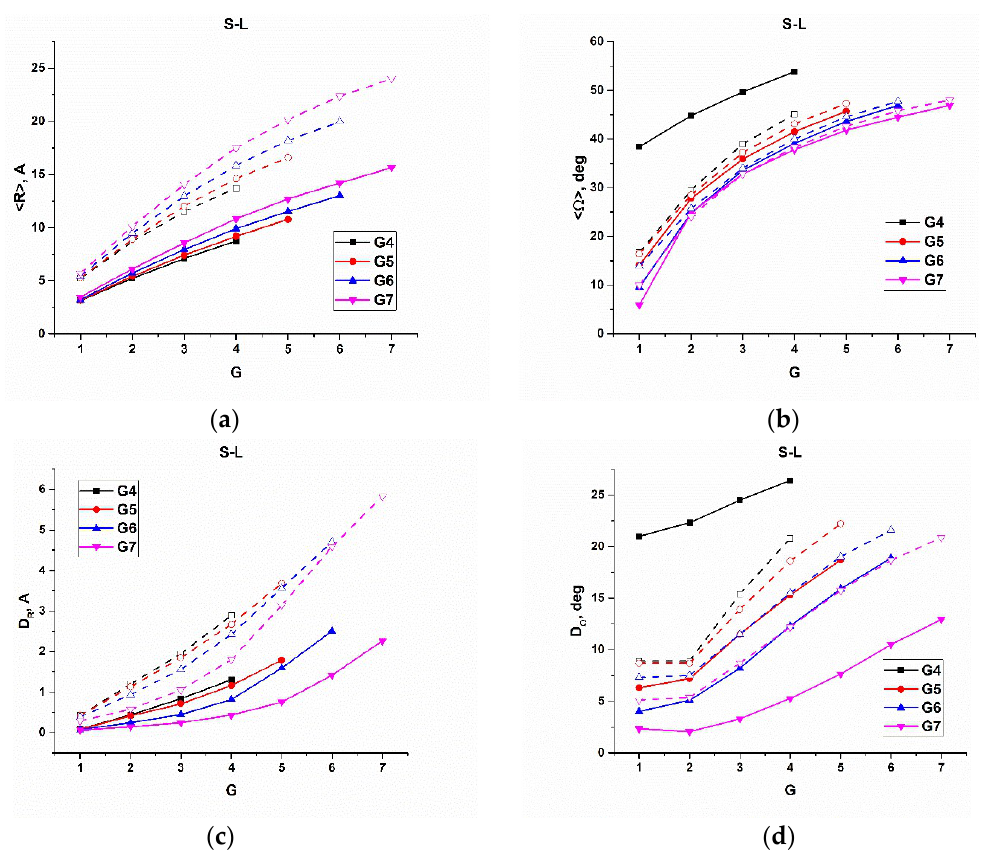
Figure 5. ( a ) The average distance, <R>, of the Si branching atoms to the core atom, ( b ) the average angle, <Ω>, between the Si atom and the center of mass of the dendron ( c ) the square root of the R dispersion, D R , and ( d ) the square root of the Ω dispersion, D Ω , calculated for s-dendrimers (solid lines) and for l-dendrimers (dashed lines).